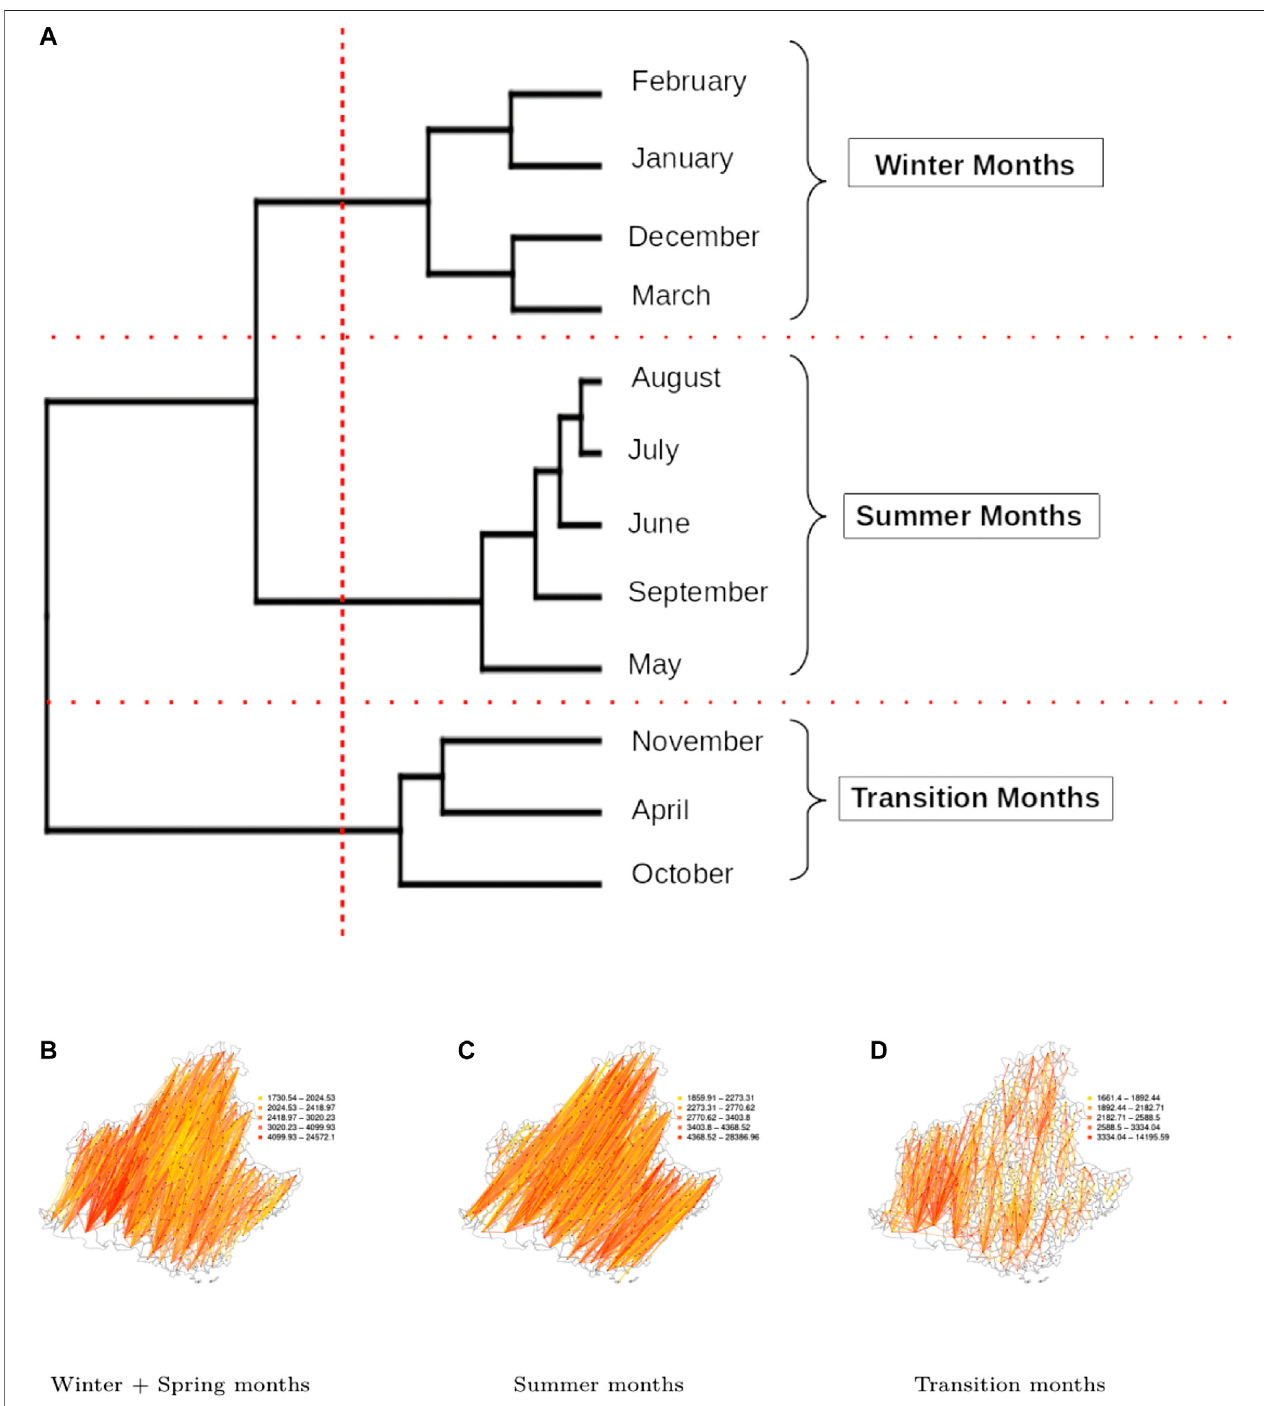
FIGURE 7 | Clustering according to the indices calculated over the PACA spatio-temporal network: (A) : Dendrogram of the months obtained from a hierarchical clusteranalysisofthePACAspatio-temporalnetworkbasedonthemonthlydissimilaritiesoftheindicespresentedin Table2 . (B) , (C), and (D) :Networkscorresponding to the three identi fi ed